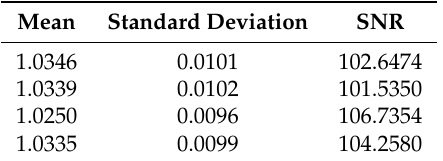
Table 1. Signal to noise ratio (SNR) of acceleration signal at